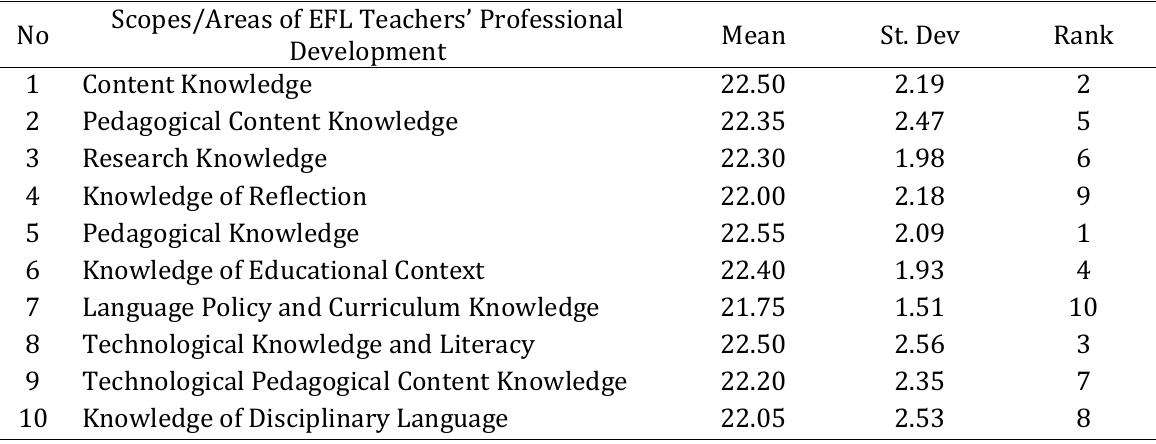
Table 5: The Needs of EFL Teachers on EFL Teachers' Professional Development